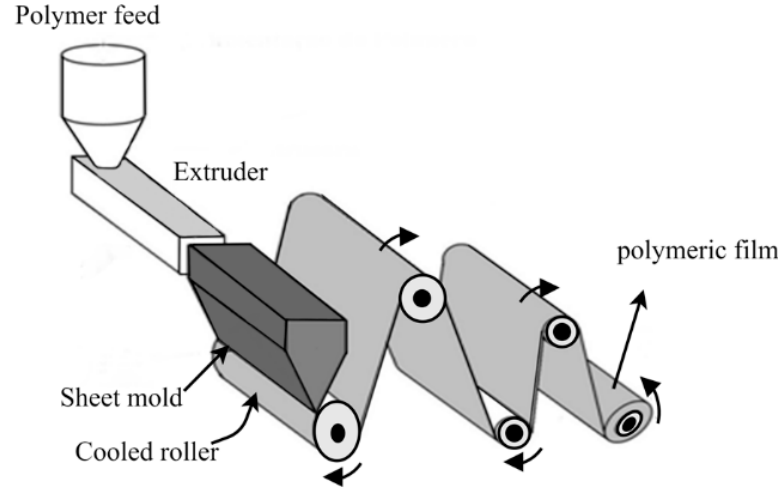
Figure 11. Illustration of the extrusion-spreading machine to film production.